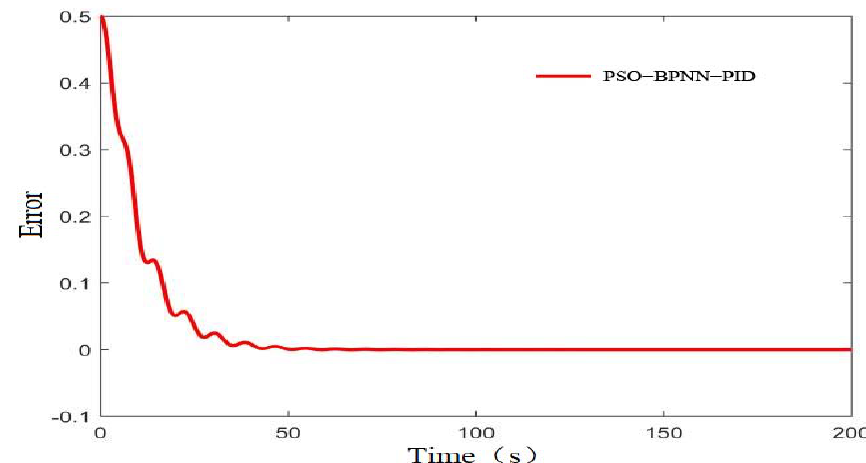
Figure 9. Error curve.